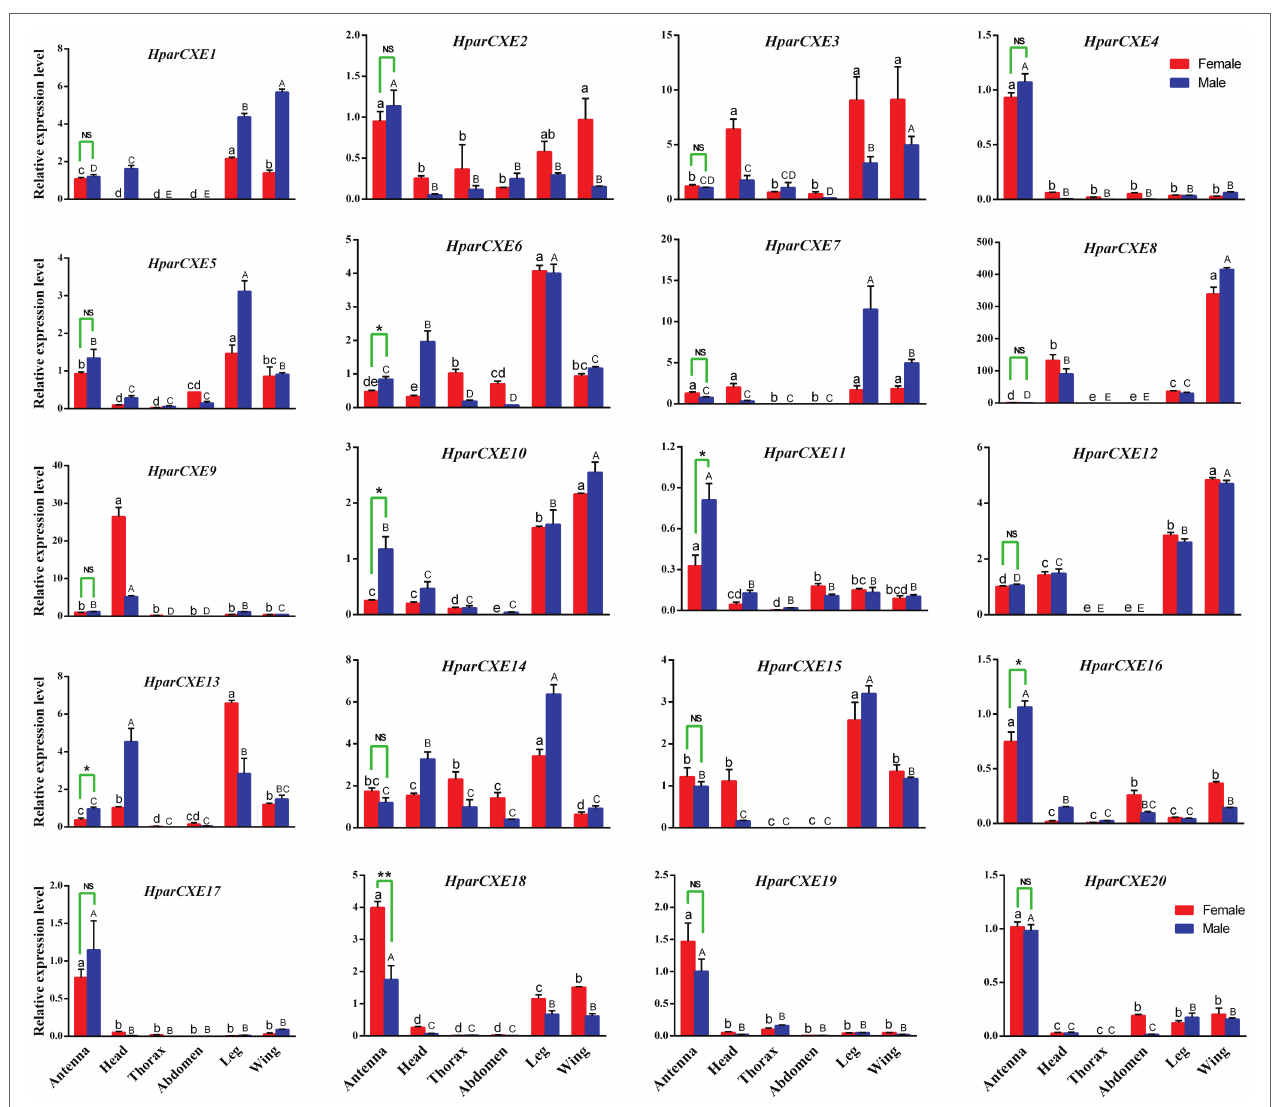
FIGURE 3 | Real-time quantitative PCR validation of CXE expression levels between different sexes and tissues. Different asterisks indicate significant differences between male and female antennae ( t -test, *, p < 0.05; **, p < 0.01; NS, no statistical significance). The uppercase and lowercase letters represent the significant differences among different male and female tissues, respectively, using one-way